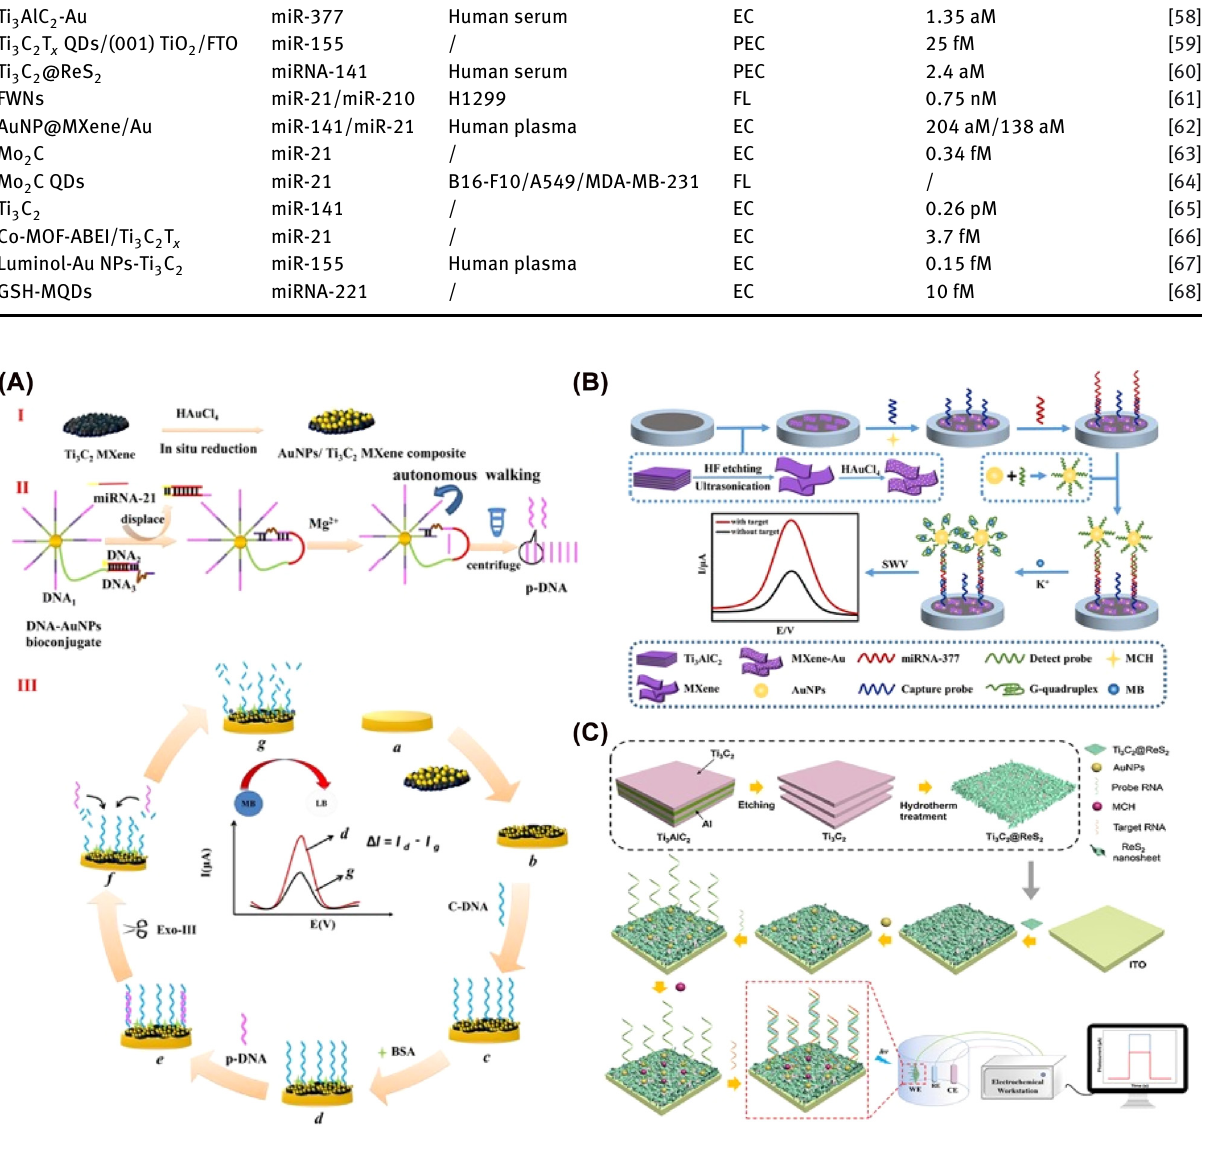
Figure 3: Application of MXenes in microRNA detection. (A) Gold nanoparticles (AuNPs)-decorated Ti electrochemical biosensor. By combining with a cascaded signal amplification strategy, miRNA-21was sensitivity detected. (B) Ti nanocomposites and G-quadruplex nano-amplification based electrochemical biosensor. (C) Ti adapted from references [58, 60,